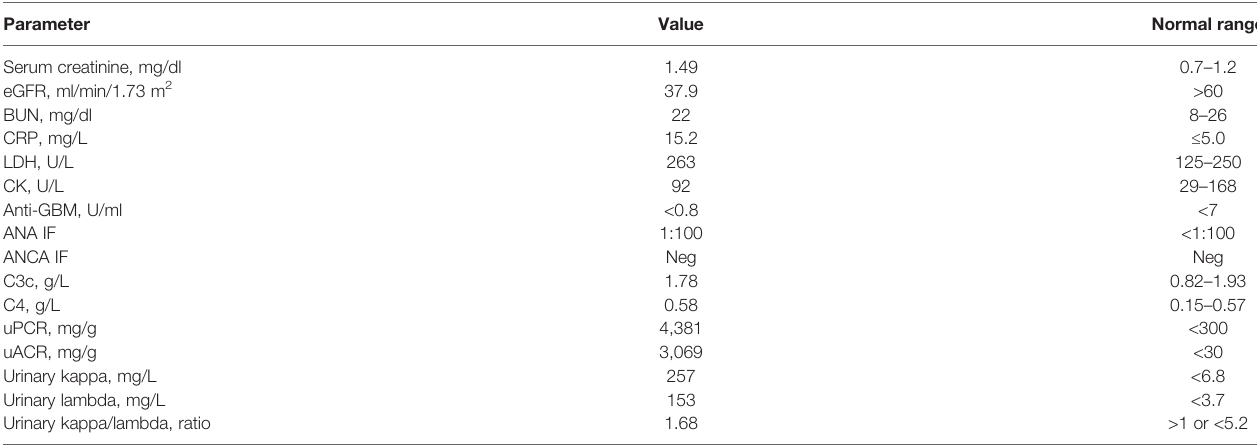
TABLE 1 | Key clinical parameters at presentation.